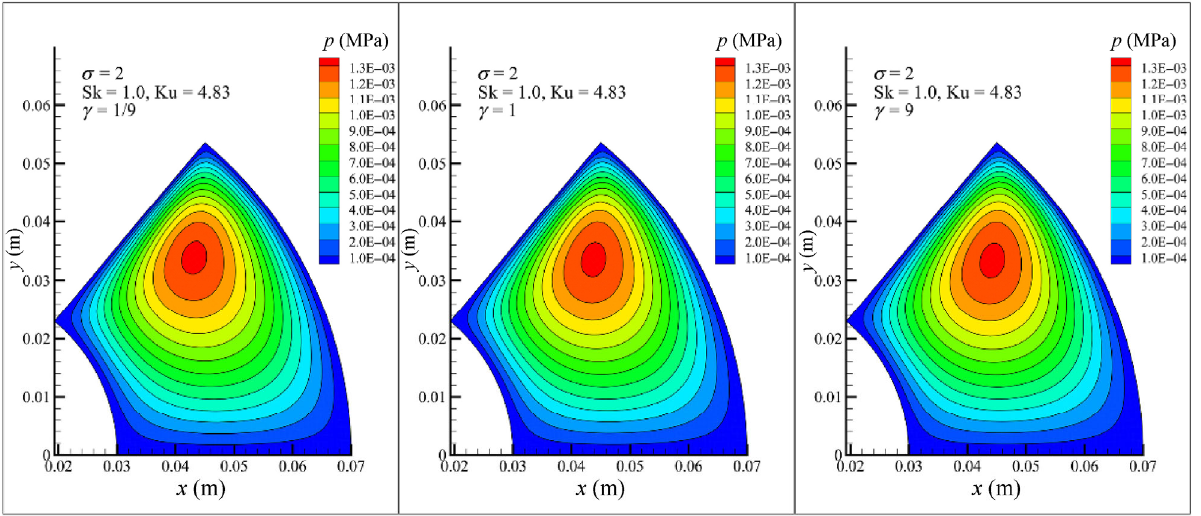
Fig. 10 Average fluid pressure distributions with various  Sk = 1, Ku